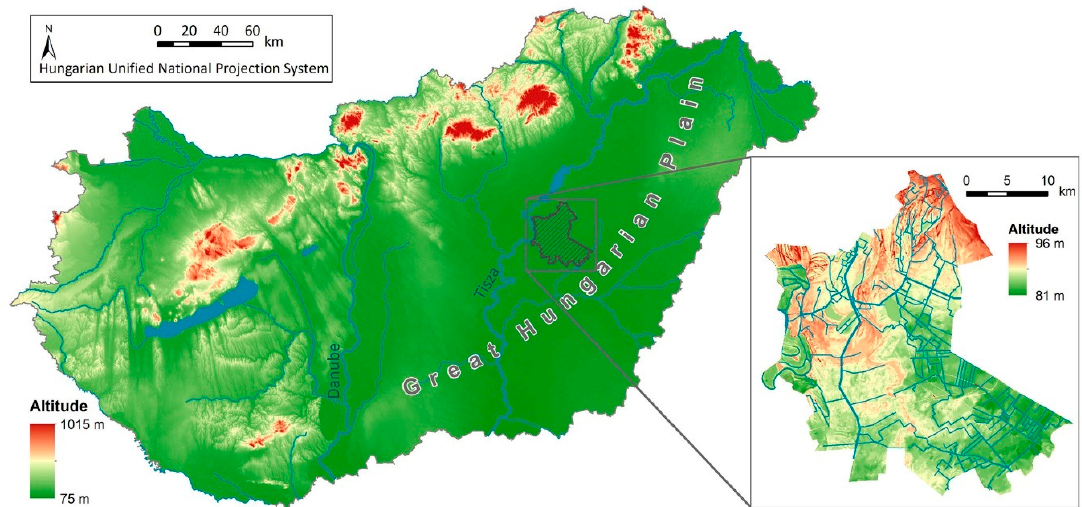
Figure 1. Overview map with relief of Hungary and the Study Area (‘10.07. Kisújszállás Excess Water Protection Section’).